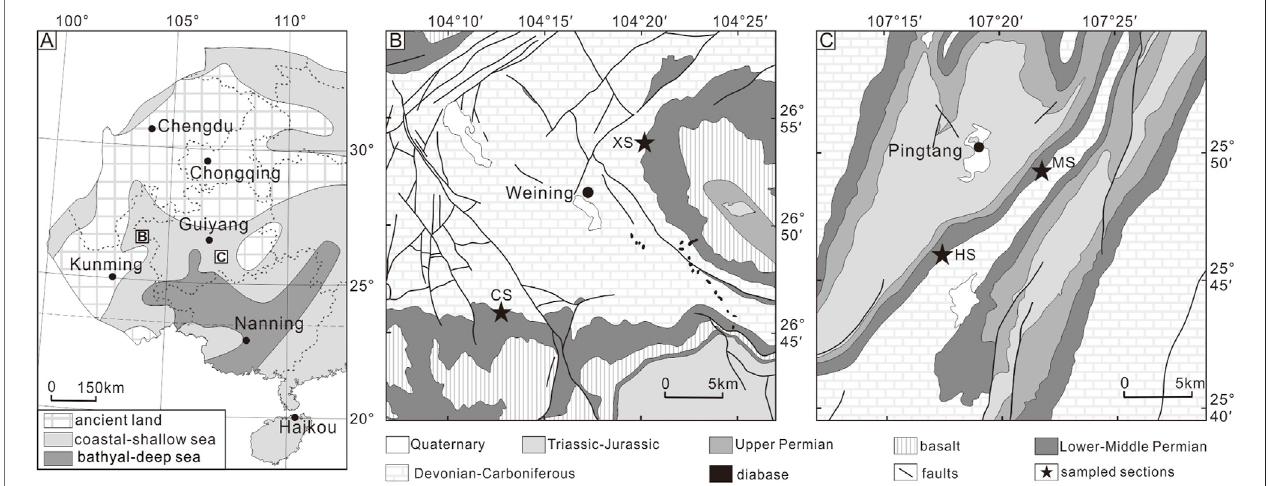
FIGURE 1 | Locations of the studied sections (XS: Xiuhe section, CS: Caohai section, HS, Houpo section, and MS: Mapojiao section) in the paleogeographic reconstruction for the deposition of early Permian Liangshan Formation in western South China ( A , revised from Liu and Xu, 1994) and geologic maps in Weining and Pingtang regions ( B,C , after GZBGMR, 1987).